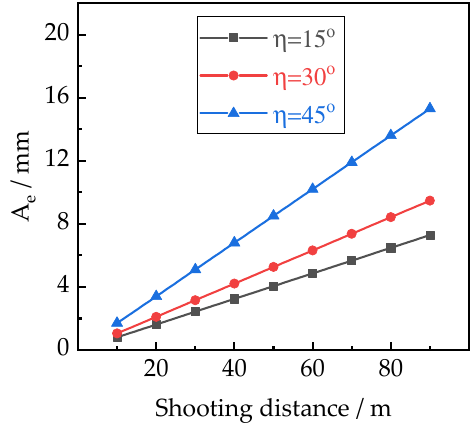
Figure 3. The effect of shooting distance.